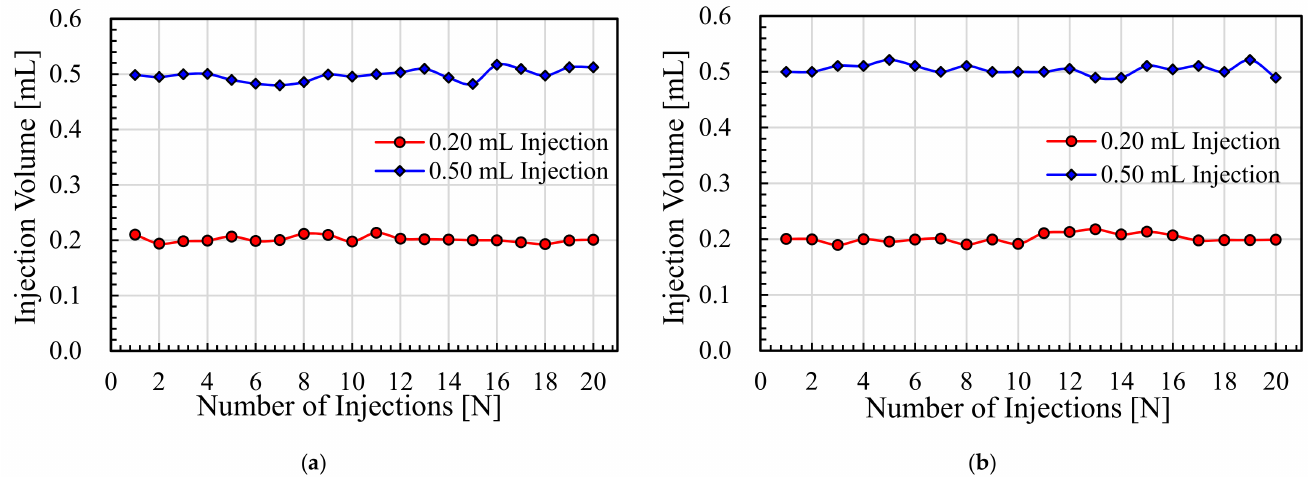
Figure 14. Injection volume measurement results for variable volume delivery. ( a ) Injections using 170 cP liquid silicon by Brookfield, and ( b ) injections using the Merial 206 vaccine using the NFJIS.